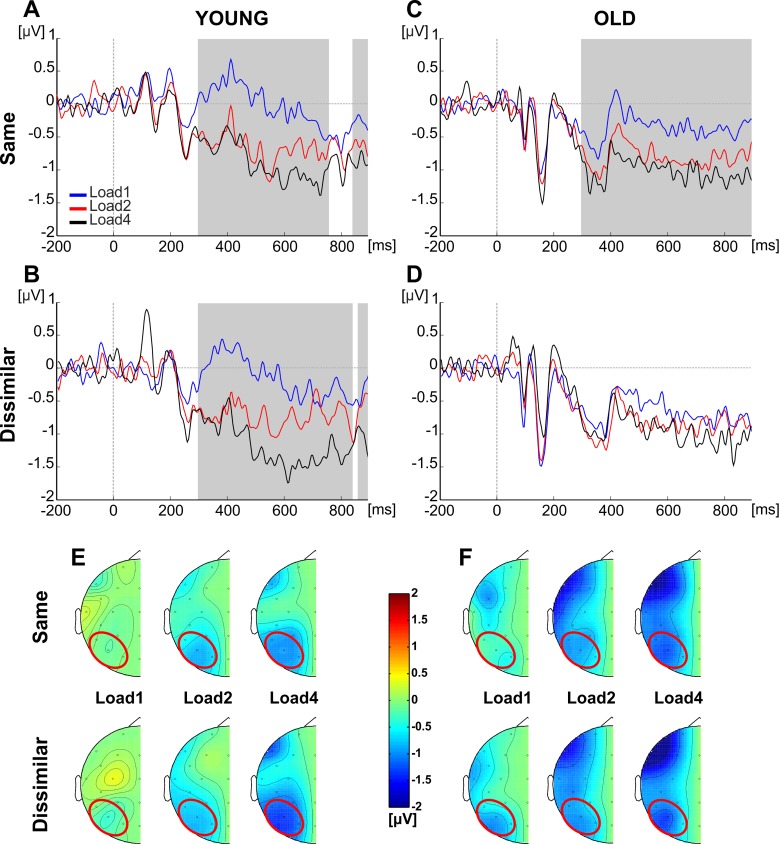
Contralateral delay activity.Grand average difference waveforms as a function of target load over the ROI (P7/8, PO7/8, O1/2). (A) Young–same numerosity. (B) Young–dissimilar numerosity. (C) Old–same numerosity. (D) Old–dissimilar numerosity. Grey squares indicate the significant time windows for the comparison between Load1 and Load4. (E, F) Topographical representations of the effects of load and similarity in the CDA time range in the Young (E) and Old (F) groups. Data were projected over one hemisphere only, as target side was collapsed. Red circles indicate the ROI considered to compute the CDA.